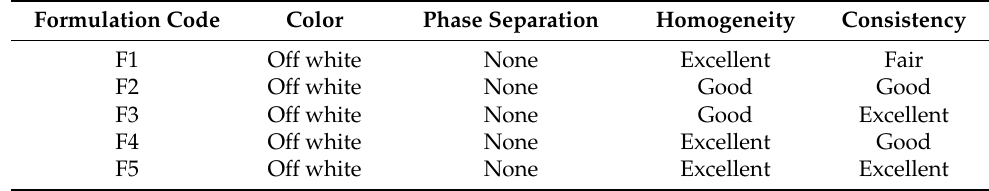
Table 2. Physical characteristics of all